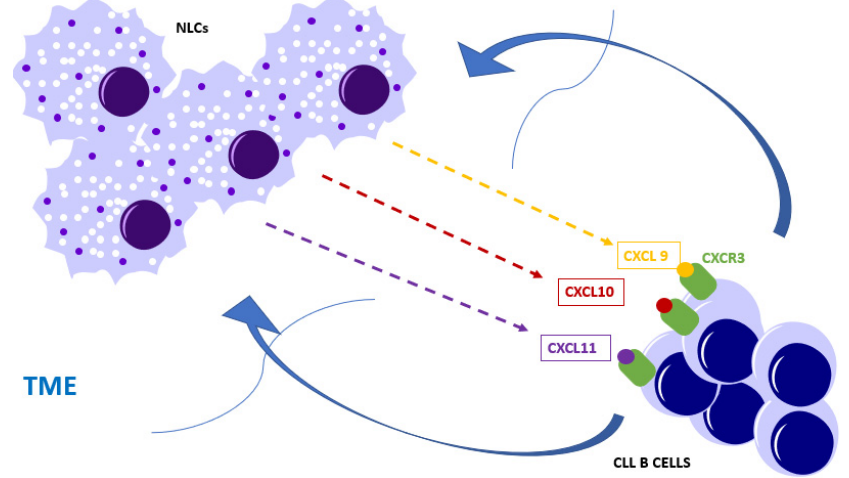
Figure 2. Nurse-like cells (NLCs), along with endothelial cells, fibroblasts and monocytes, secrete chemokines like CXCL9, CXCL10, CXCL11, which will bind the CXCR3 receptor expressed on the chronic lymphocytic leukemia (CLL) B cells and attract the cells into the tumor microenvironment (TME).